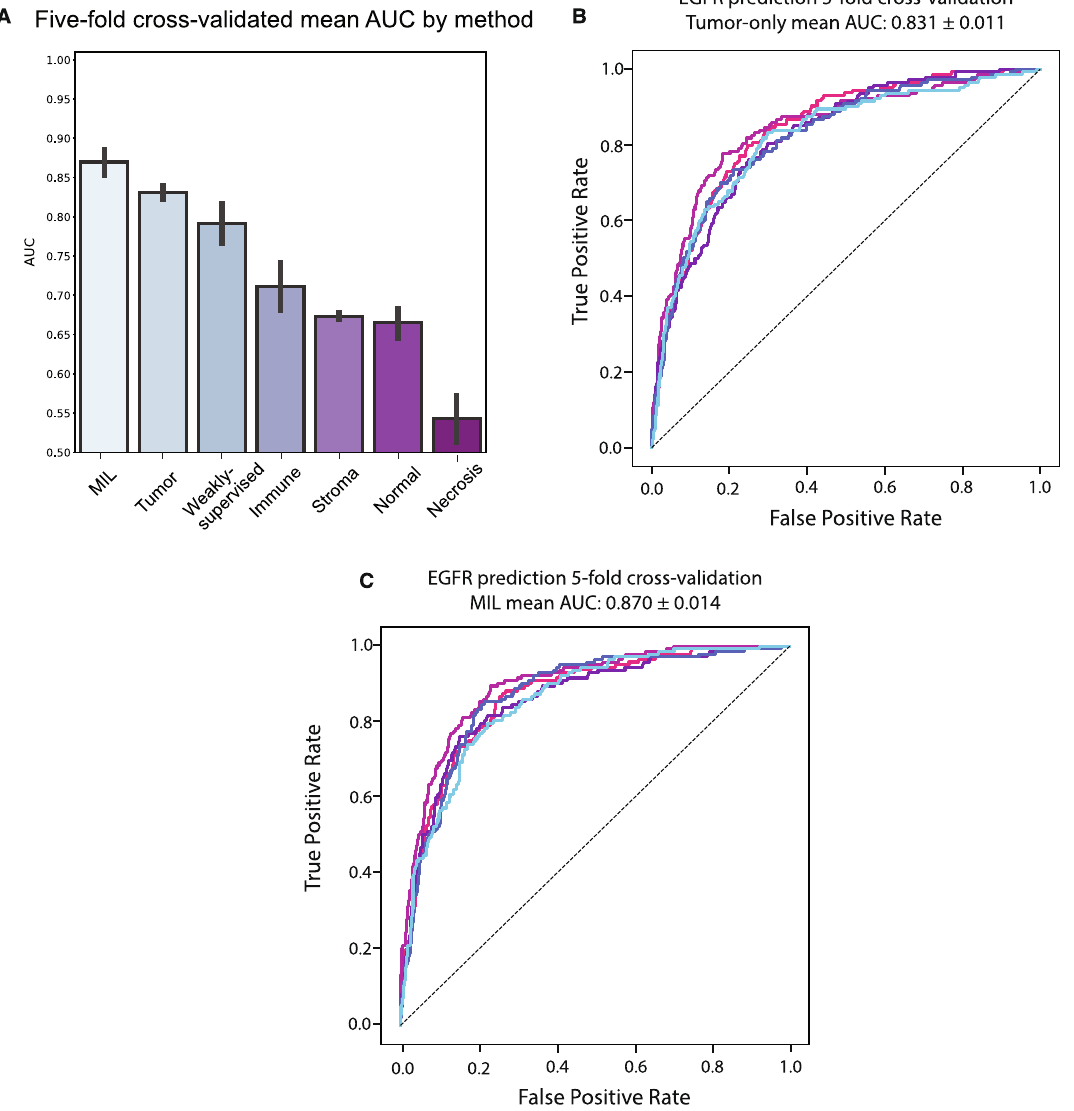
Figure 2. Performance for deep learning models to predict tissue morphology and EGFR mutational status. (a) Comparison of all deep learning models for predicting EGFR status from H&E images. (b,c) Cross-validated receiver operator characteristic curve for each cross-fold of (b) the tumor-only two-stage EGFR model and (c) the MIL